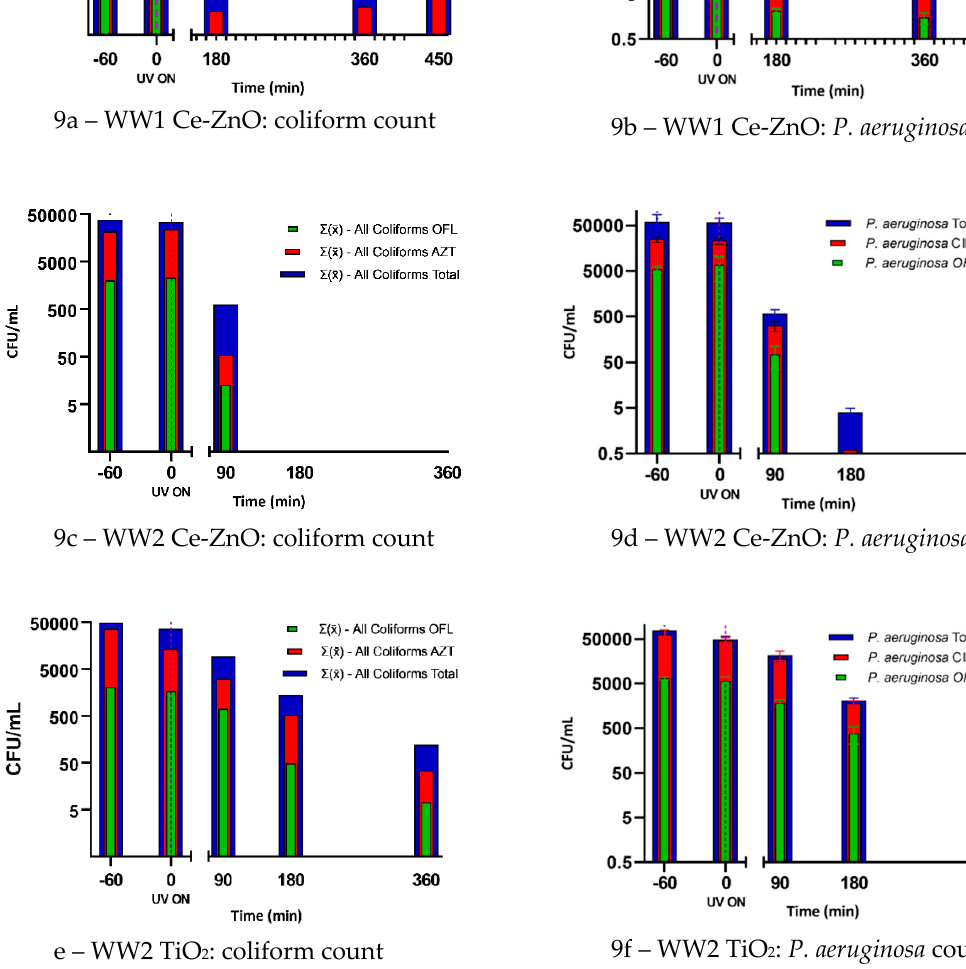
Figure 9. The inactivation of bacteria and their resistant fractions. Inactivation by Ce-ZnO on the sum of E. coli and other coliforms in WW1 ( 9a ) and WW2 ( 9c ) and on P. aeruginosa in WW1 ( 9b ) and WW2 ( 9d ). The effect of TiO 2 -P25 on the sum of E. coli and coliforms in WW2 ( 9e ) and on P. aeruginosa in WW2 ( 9f ). Conditions: 750 mL of WW and 380 cm 2 photocatalyst coated discs with 36 W